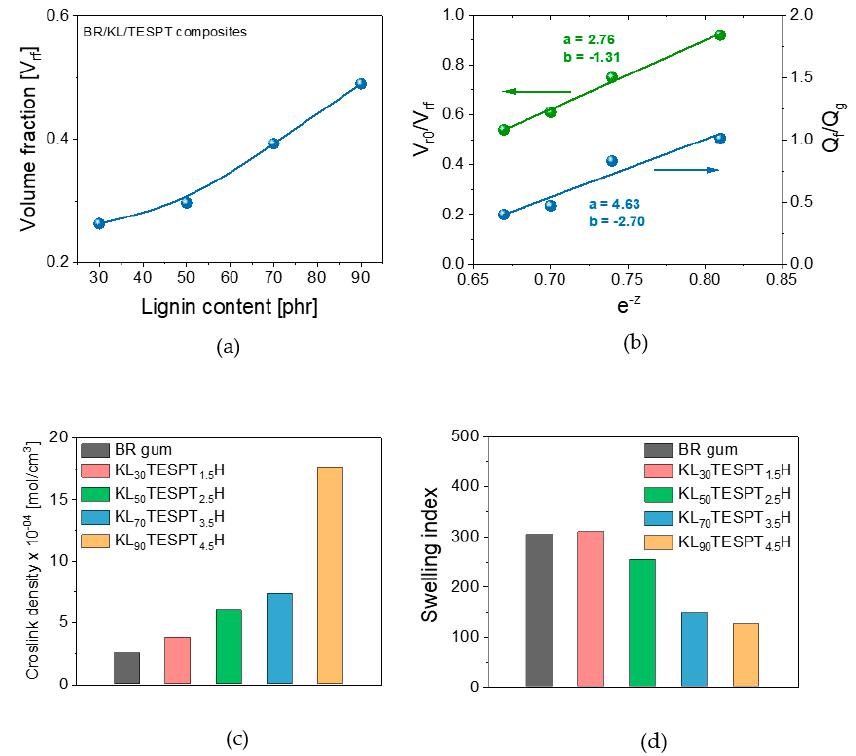
(cid:16) (cid:17) V ro V rf